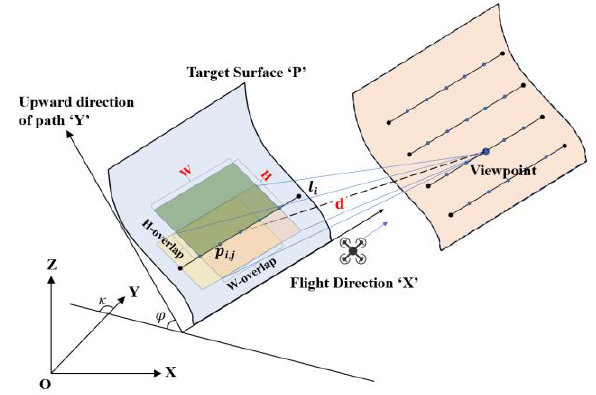
Figure 4 . The generation of structure lines, aerial strips, and viewpoints.